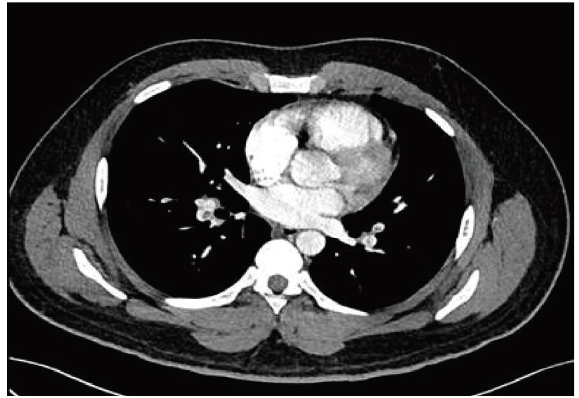
Figure 2: Extensive bilateral pulmonary emboli seen on chest CT